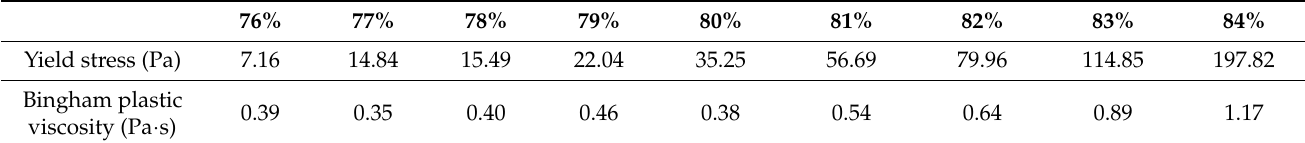
Table 1. Rheological parameters based on the flow curve fitting by Bingham model.